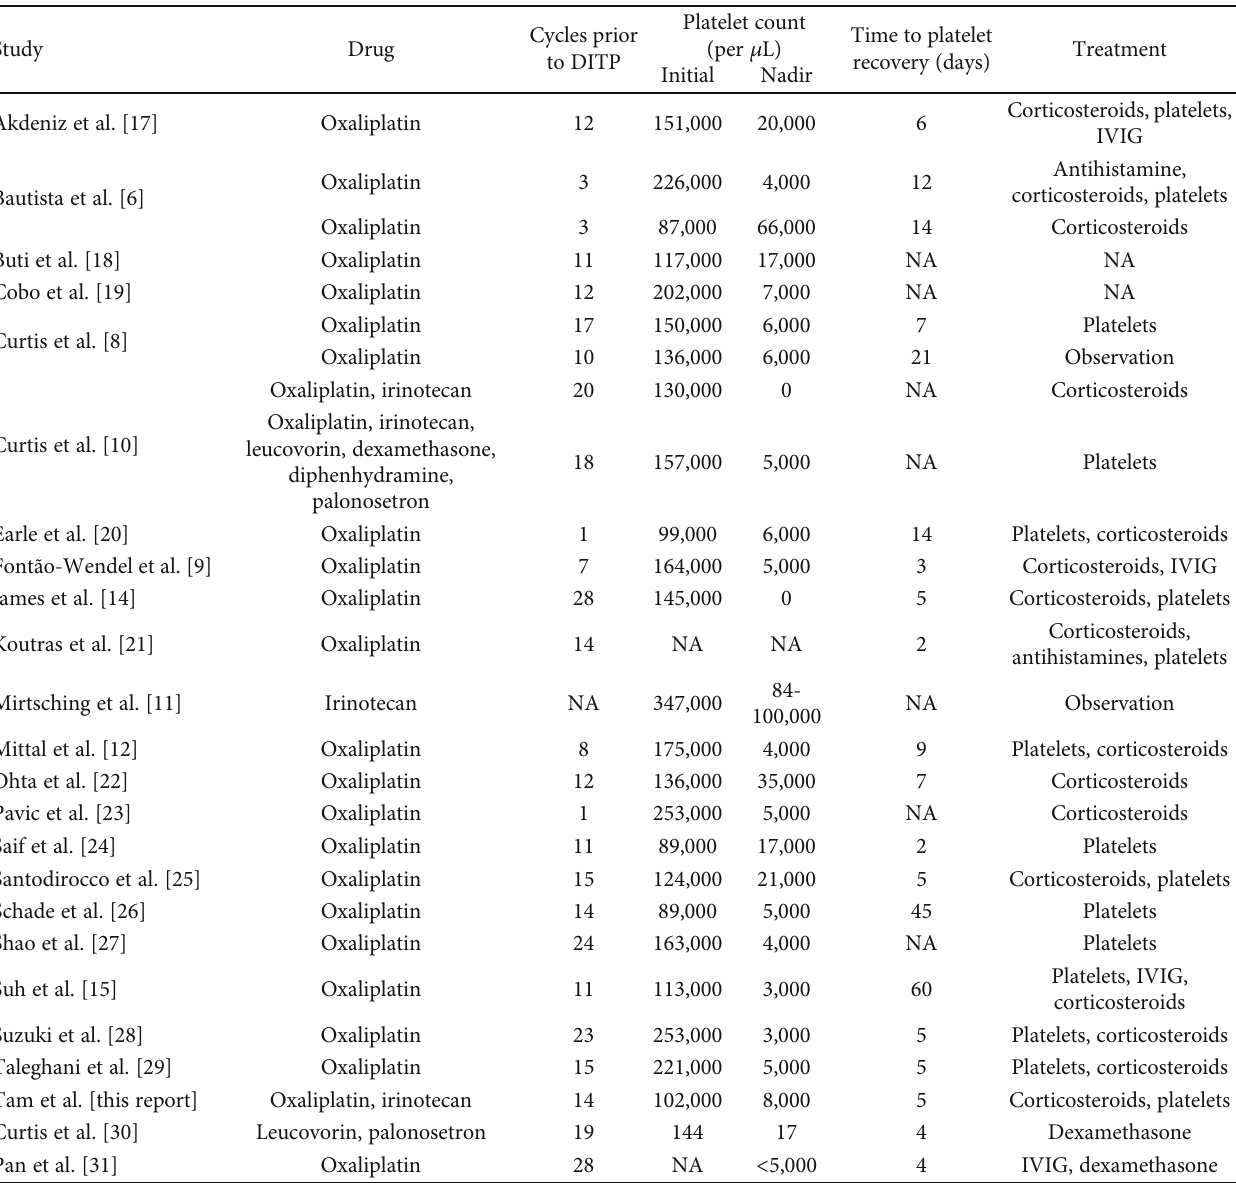
Table 1: Known cases of oxaliplatin and irinotecan drug-induced immune-mediated thrombocytopenia. IVIG=intravenous